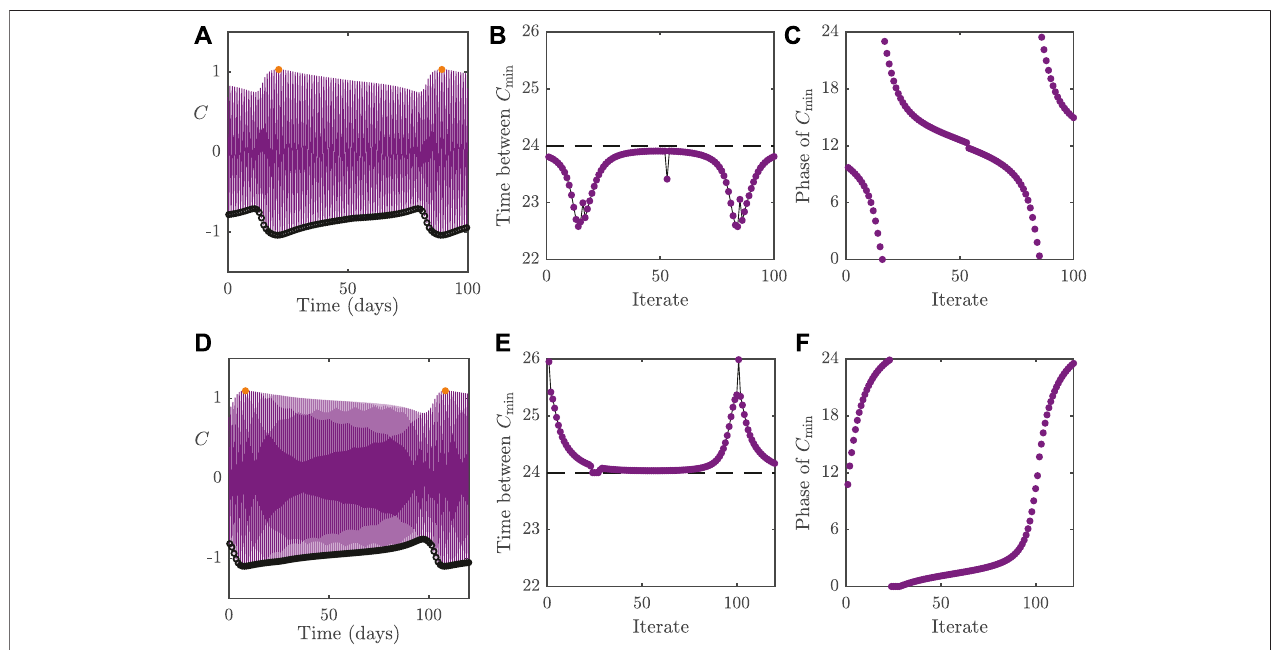
FIGURE5| Dynamicsofthe2Dmodelwith I (cid:1) 50at τ c valuesjustbeyondthefoldbifurcationpointswith τ c (cid:1) 23 . 3 < τ F1 c [panels (A – C) ]and τ c (cid:1) 24 . 8 > τ F4 c [panels (D – F) ]. (A) + (D) :Trajectoriesof C highlightingmodulationintheamplitudeofthecircadianoscillations.Openblackcirclesindicatethedaily C min values,andsolidorange circlesindicate thepeak values of C forthe longertimescaleamplitude modulation, whichhas aperiod of ∼ 68 days inpanel (A) and ∼ 100 days inpanel (D) . (B) + (E) : Evolution of the interval between successive C min values. Dashed lines indicate entrainment to a 24 h rhythm. (C) + (F) : Evolution of the phase of the C min values relative to the forcing phase.